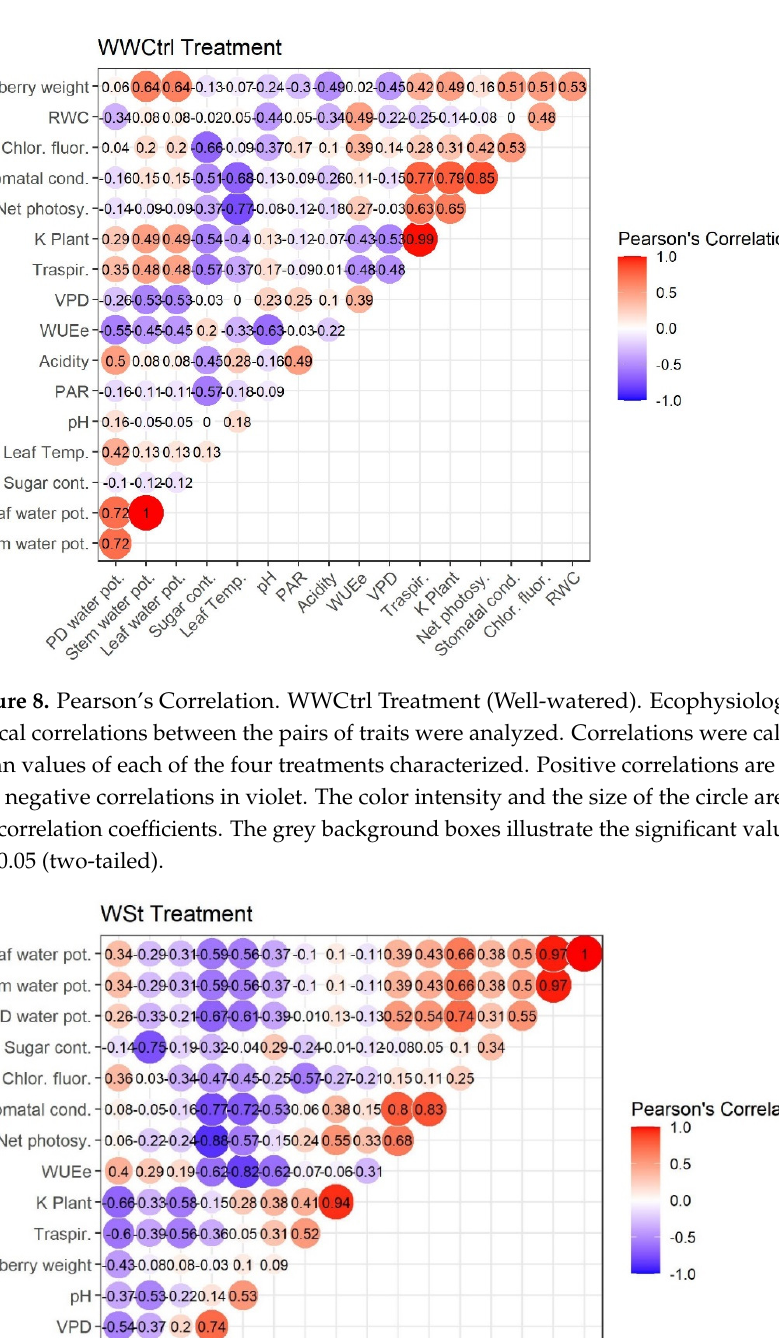
Figure 7. Pearson’s Correlation. WWt Treatment (Well-watered + Zeolite). Ecophysiological and technological correlations between the pairs of traits were analyzed. Correlations were calculated from the mean values of each of the four treatments characterized. Positive correlations are dis- played in red and negative correlations in violet. The color intensity and the size of the circle are proportional to the correlation coefficients. The grey background boxes illustrate the significant val- ues at the level of p < 0.05 (two-tailed).